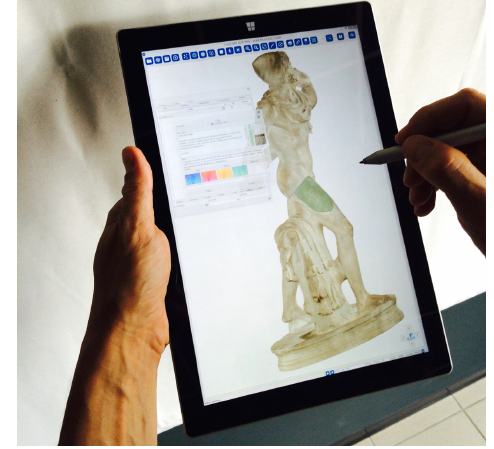
Figure 12. Decay segmentation